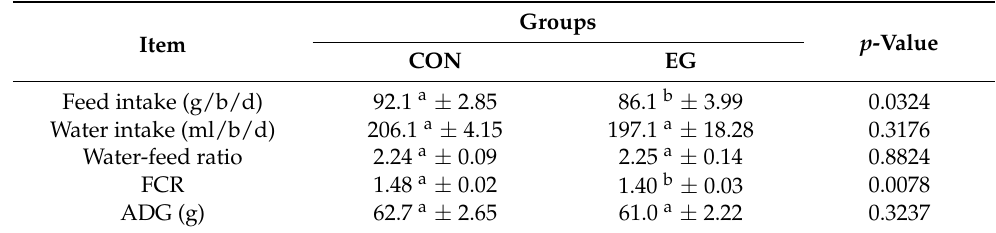
Table 3. Feed intake (g/bird/day), water intake (ml/bird/day), water/feed ratio, mortality corrected FCR, and average daily gain (g) of broilers from five runs (mean ± SD). Groups p -Value Item CON EG Feed intake (g/b/d) 92.1 a ± 2.85 Water-feed